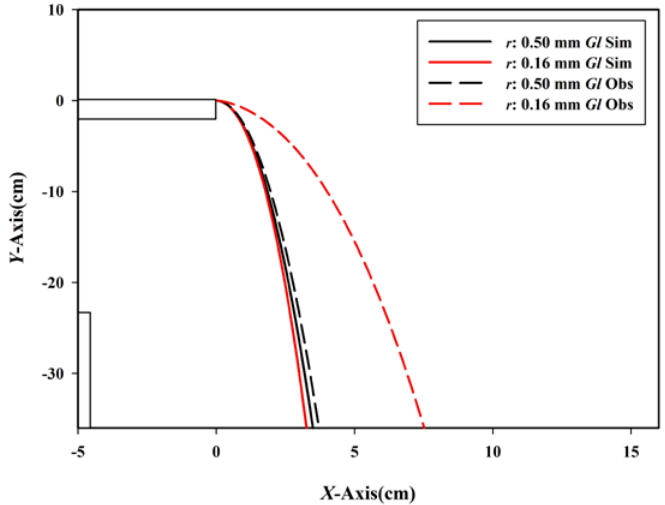
Figure 12. Observed vs. simulated trajectories of pretreated large and small glass ( Gl ) particles (applied voltage: 20 kV, relative humidity: 35%, distance between electrodes: 60 cm, initial speed: 0.13 m/s).